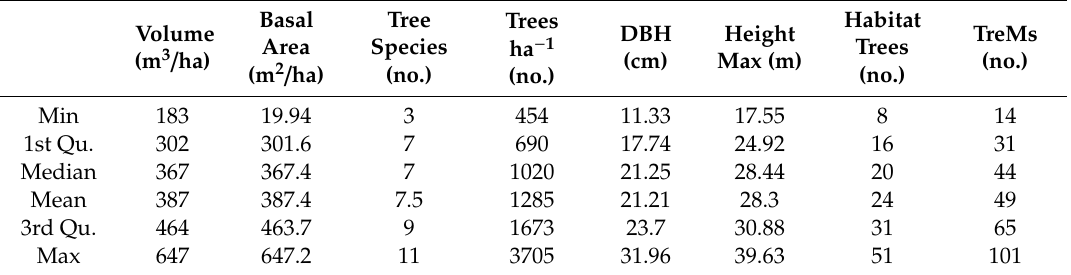
Table A1. Descriptive statistics for the average values of DBH, maximum tree height, basal area and